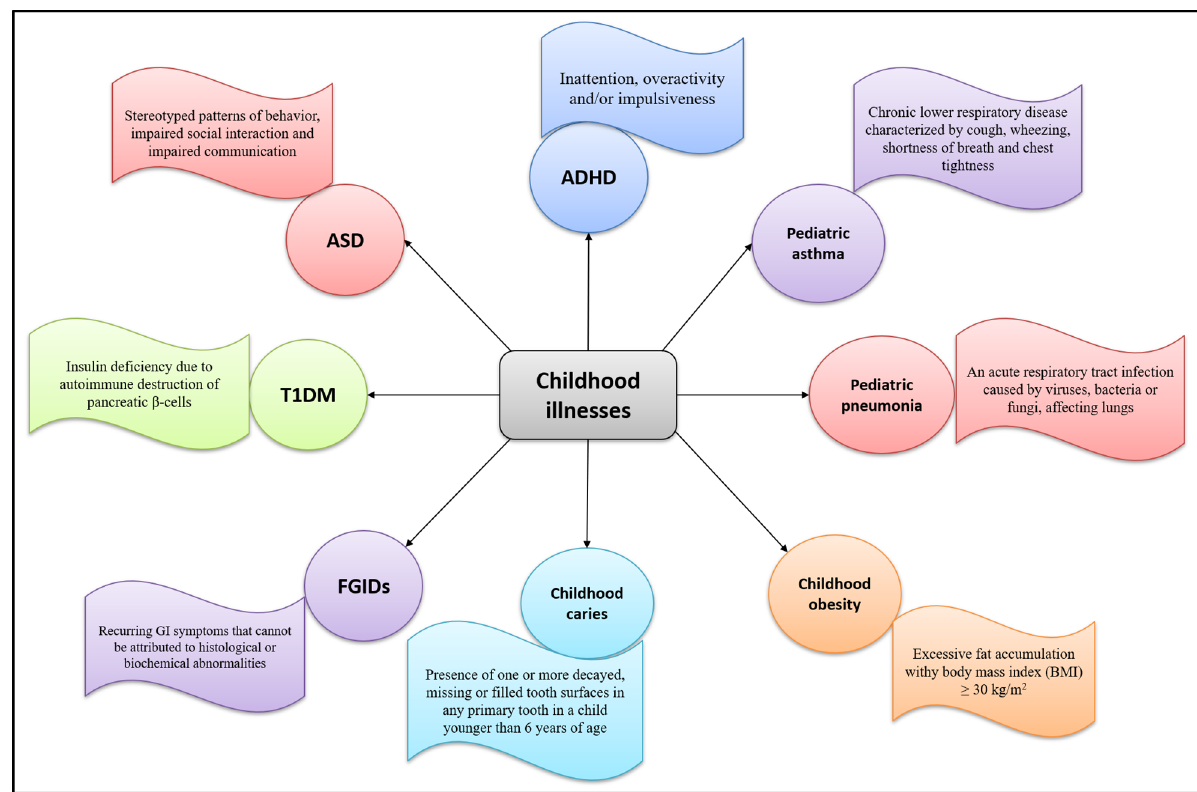
Figure 2. Common childhood illnesses and their defining features. Attention deficit hyperactivity disorder (ADHD), autism spectrum disorder (ASD), Type 1 diabetes mellitus (T1DM), functional gastrointestinal disorders (FGIDs). Table 1. Evidence of botanical extract supplementation in children from clinical trials.